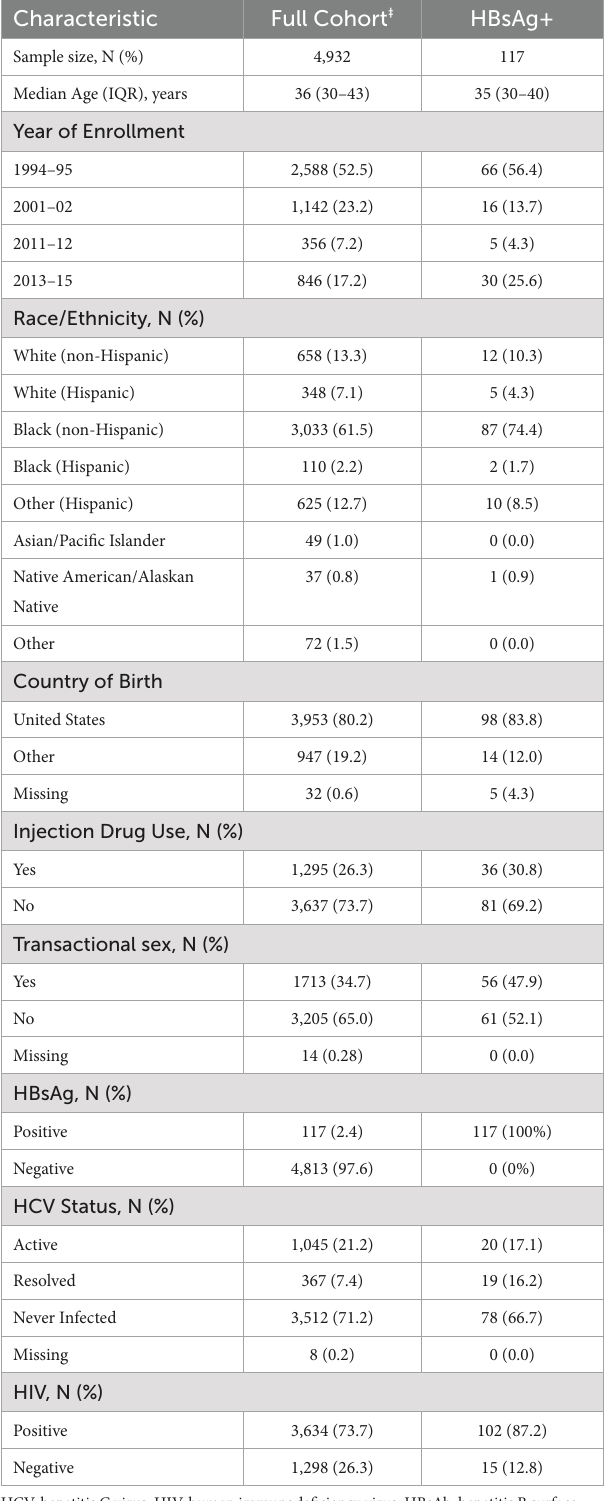
TABLE 1 Demographic, behavioral, and clinical characteristics of women screened for HBsAg at enrollment in the WIHS cohort.